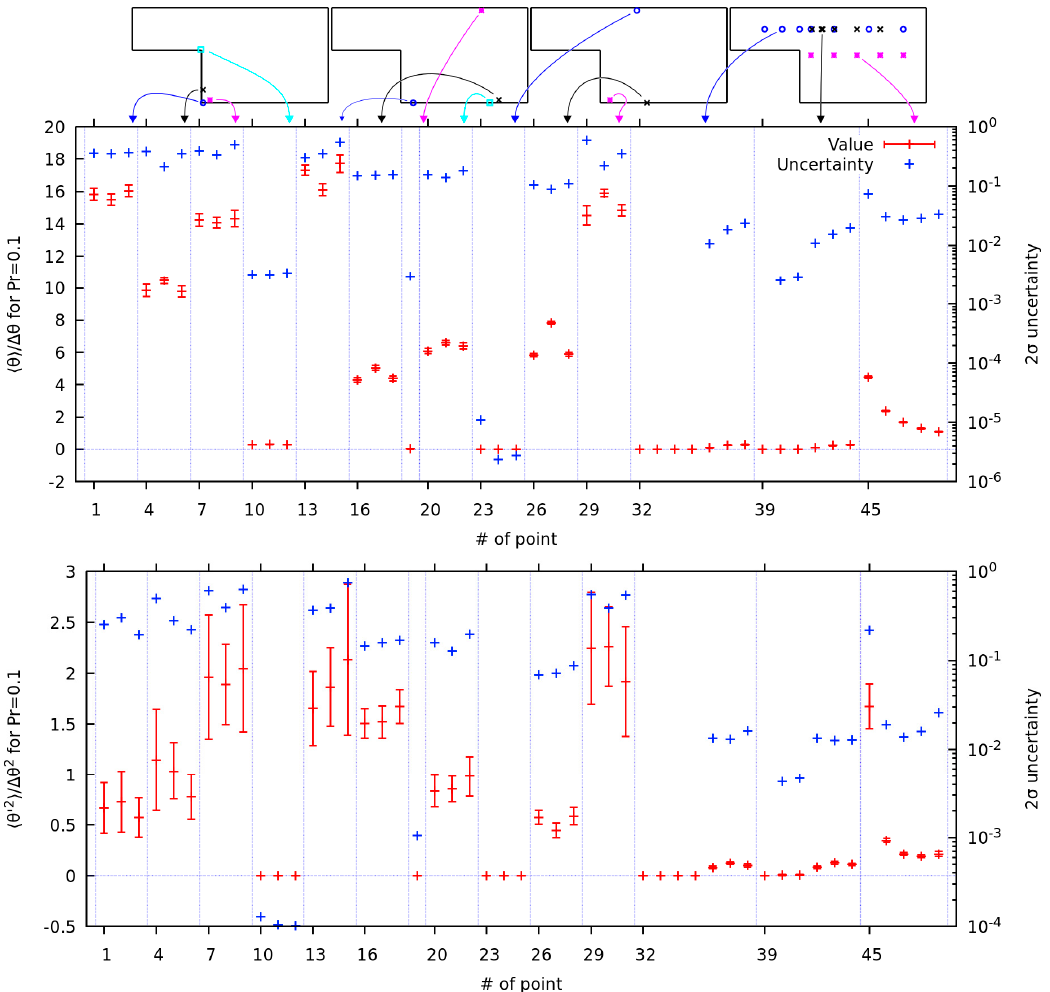
Figure 14. 𝑥 -axis: number of point according to Figure 2. Top: Mean temperature for Pr = 0.1 . Bottom: 𝜃 RMS for Pr = 0.1 . Red dots represent root-mean-square values with ± 2𝜎 range (left scale), blue dots represent ( 2𝜎 ) uncertainty (right scale).